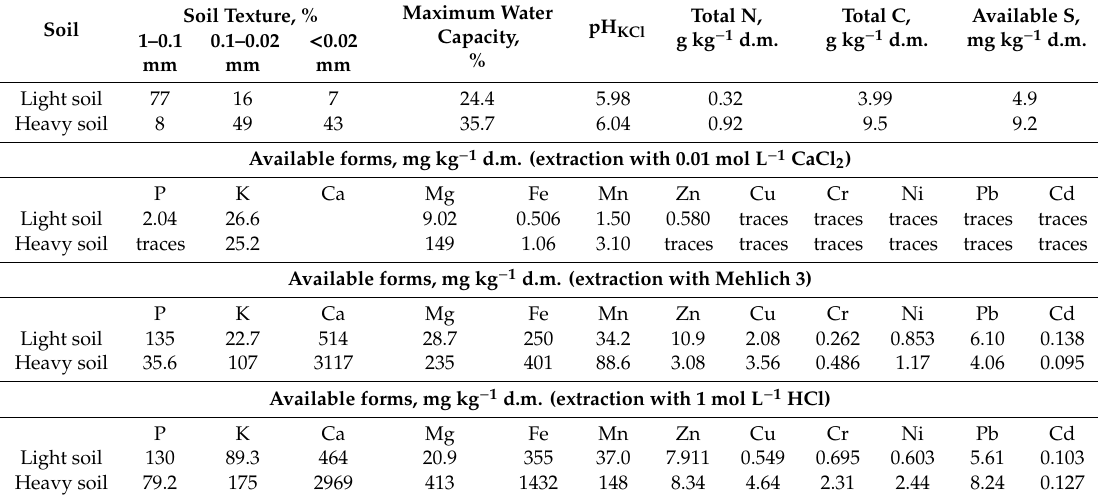
Table 1. Selected properties of soil before establishing the experiment.